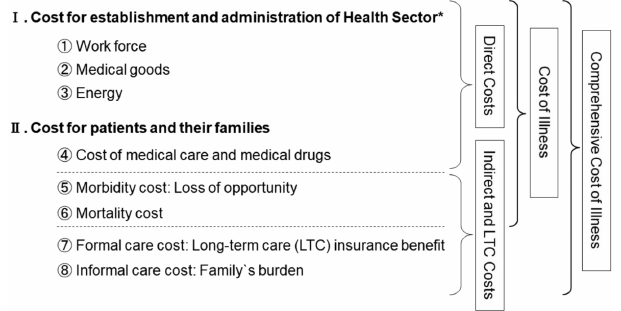
Figure 1. The structure of social burden of a